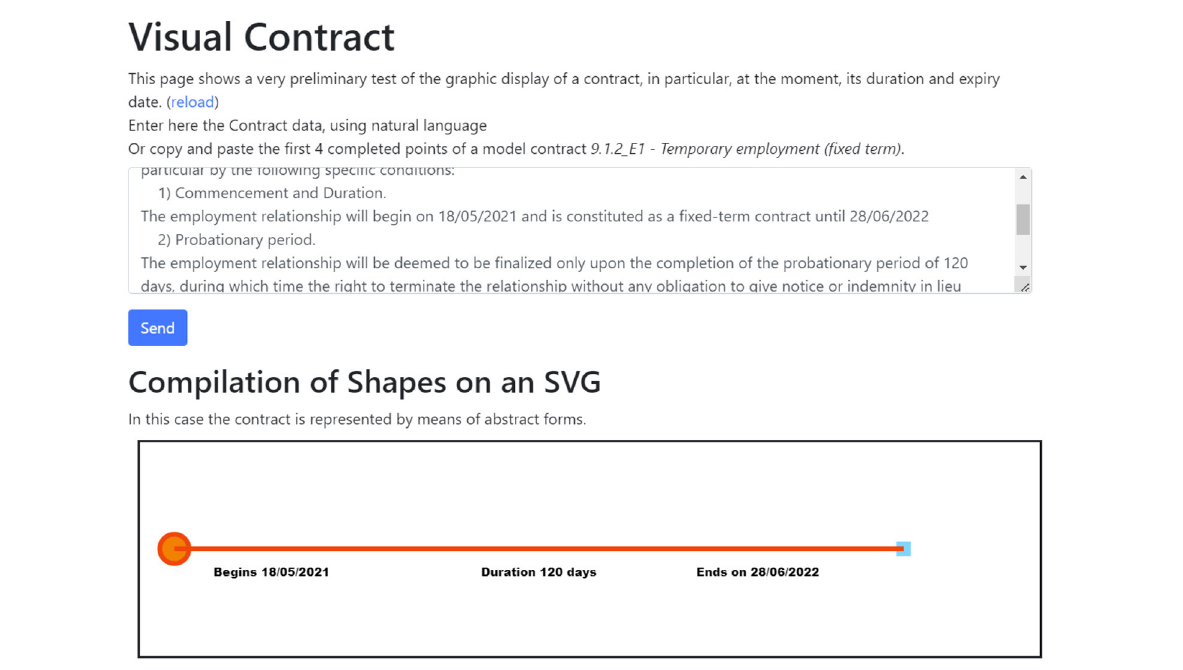
FIGURE4 Example of the automatic translation of the timeline of a contract onto an SVG canvas.